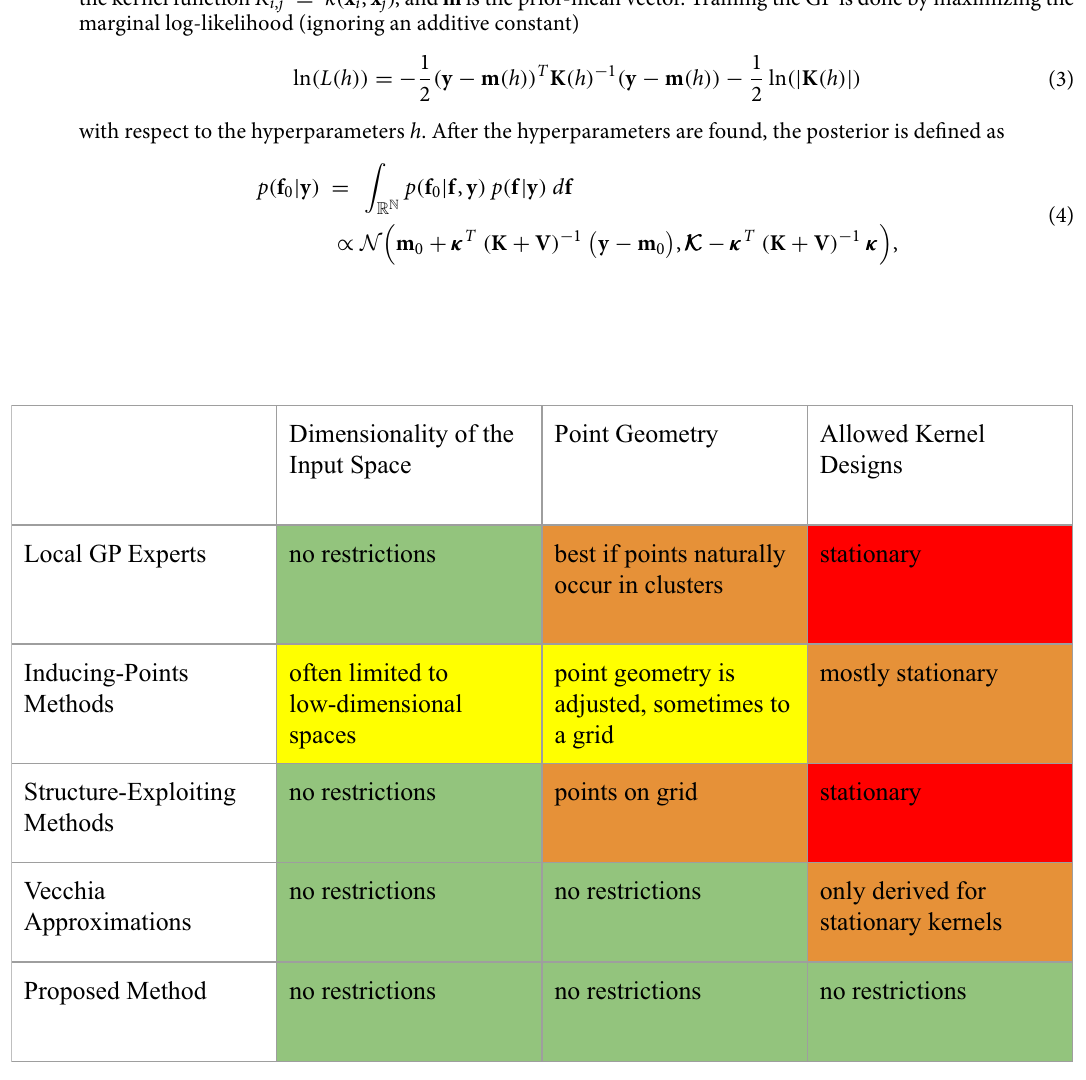
Figure 1. Table comparing the existing approximate methods for large-scale Gaussian processes and the proposed method. The proposed method is the only one with no restrictions on the dimensionality of the input space, kernel design, or data-point